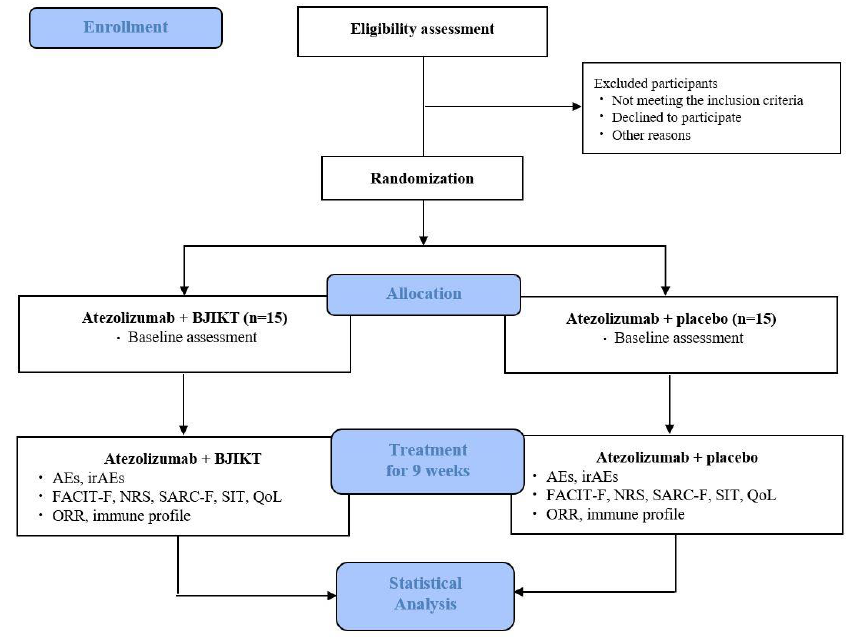
Figure 1. Study flowchart. BJIKT, Bojungikki-tang ; AE, adverse event; irAEs, immune-related adverse events; FACIT-F, Functional Assessment of Chronic Illness Therapy for Fatigue; NRS, Numeric Rating Scale; SARC-F, strength, assistance with walking, rising from a chair, climbing stairs, falls; SIT, sit-to-stand; QoL, quality of life; ORR, objective response rate. Table 1. Schedule of enrollment, interventions, and assessments.